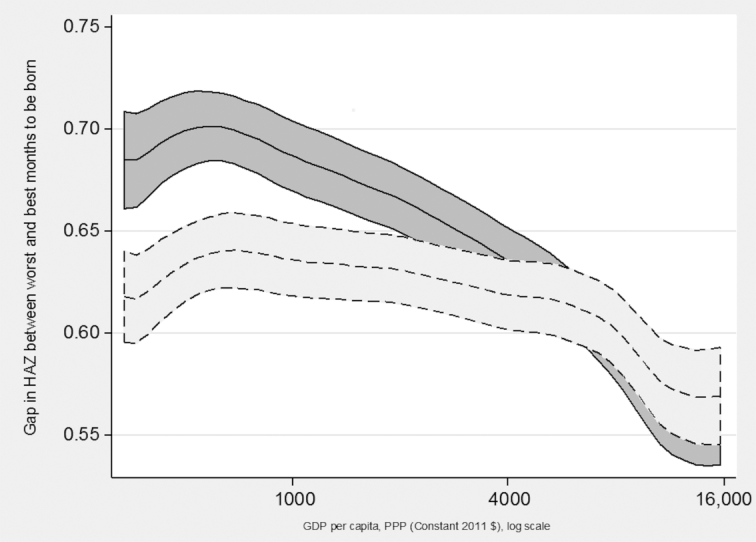
GDP and seasonality in HAZ across 218 DHS surveys: Gap between worst and best months to be born. Lines are local polynomial smoothing regressions of degree zero with 95% CIs and an Epanechnikov kernel. Solid line is estimates before the linear correction for misreported MOB. Dotted line is after the linear correction for misreported MOB. DHS, Demographic and Health Surveys; GDP, Gross Domestic Product; HAZ, height-for-age z-score; MOB, month of birth; PPP, Purchasing Power Parity.